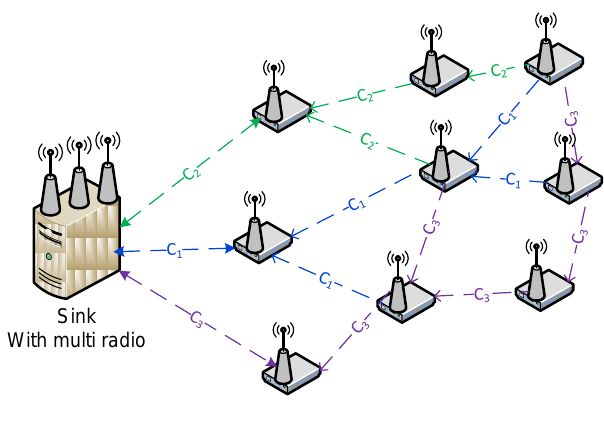
Figure 6. Single sink node with multiple